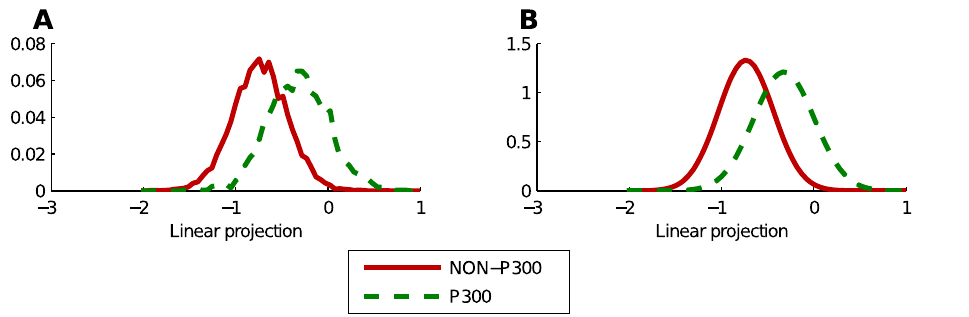
Figure 3. The projection of the EEG into one dimension produces two Gaussians. Figure A shows the histogram of the used EEG features projected into one dimension. Figure B shows two Gaussians fitted to this histogram. One Gaussian for the EEG containing the P300 response, one Gaussian for the data without P300 response. The vector w that was used in the projection was trained unsupervisedly on the data.